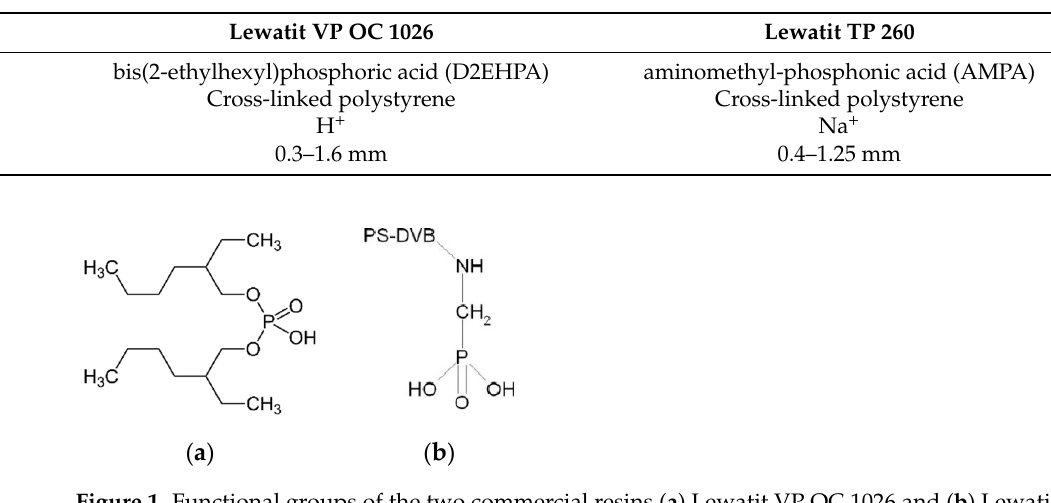
Table 2. Chemical analysis of FeCl 2 feed